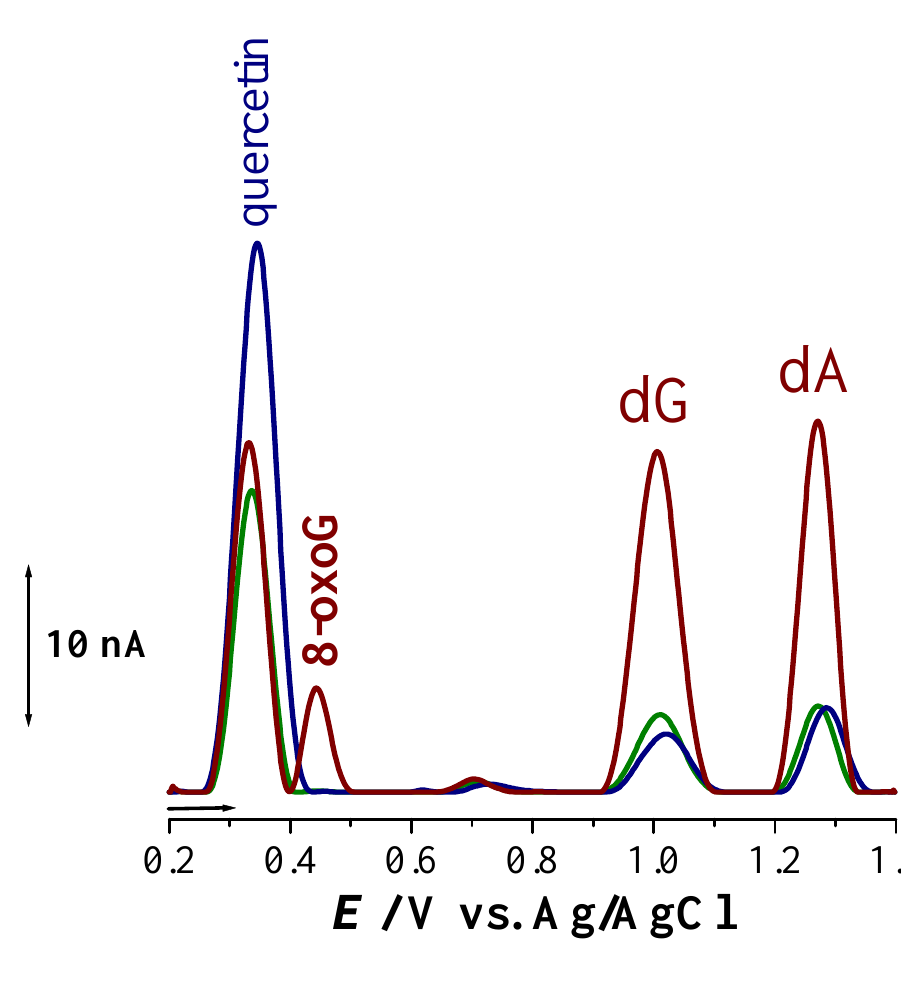
Figure 5. Differential pulse voltammograms in pH 4.3 0.1 M acetate buffer obtained with a DNA biosensor incubated in 100 µ M quercetin ( ▬ ) before and after applying +0.400 V during 300 s in ( ▬ ) normal atmosphere and in ( ▬ ) N saturated buffer solution. [From Ref [40] with 2